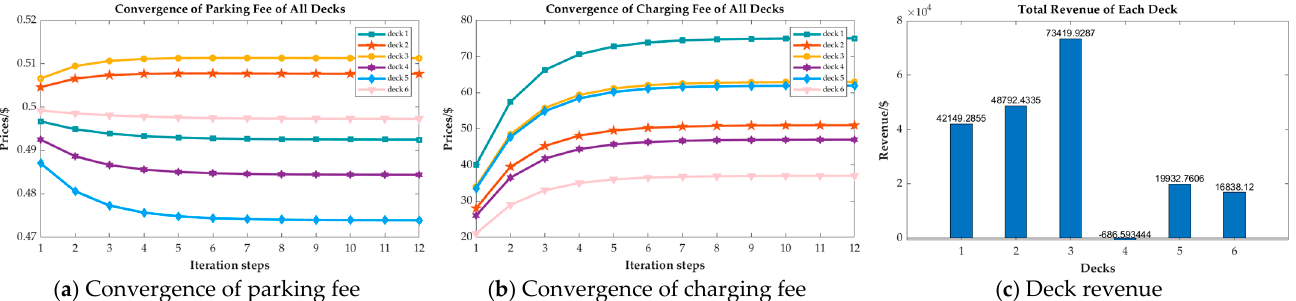
Figure 7. The electricity price, parking fee, and total revenue after halving the number of SC customers in all decks and including them in Group LC.